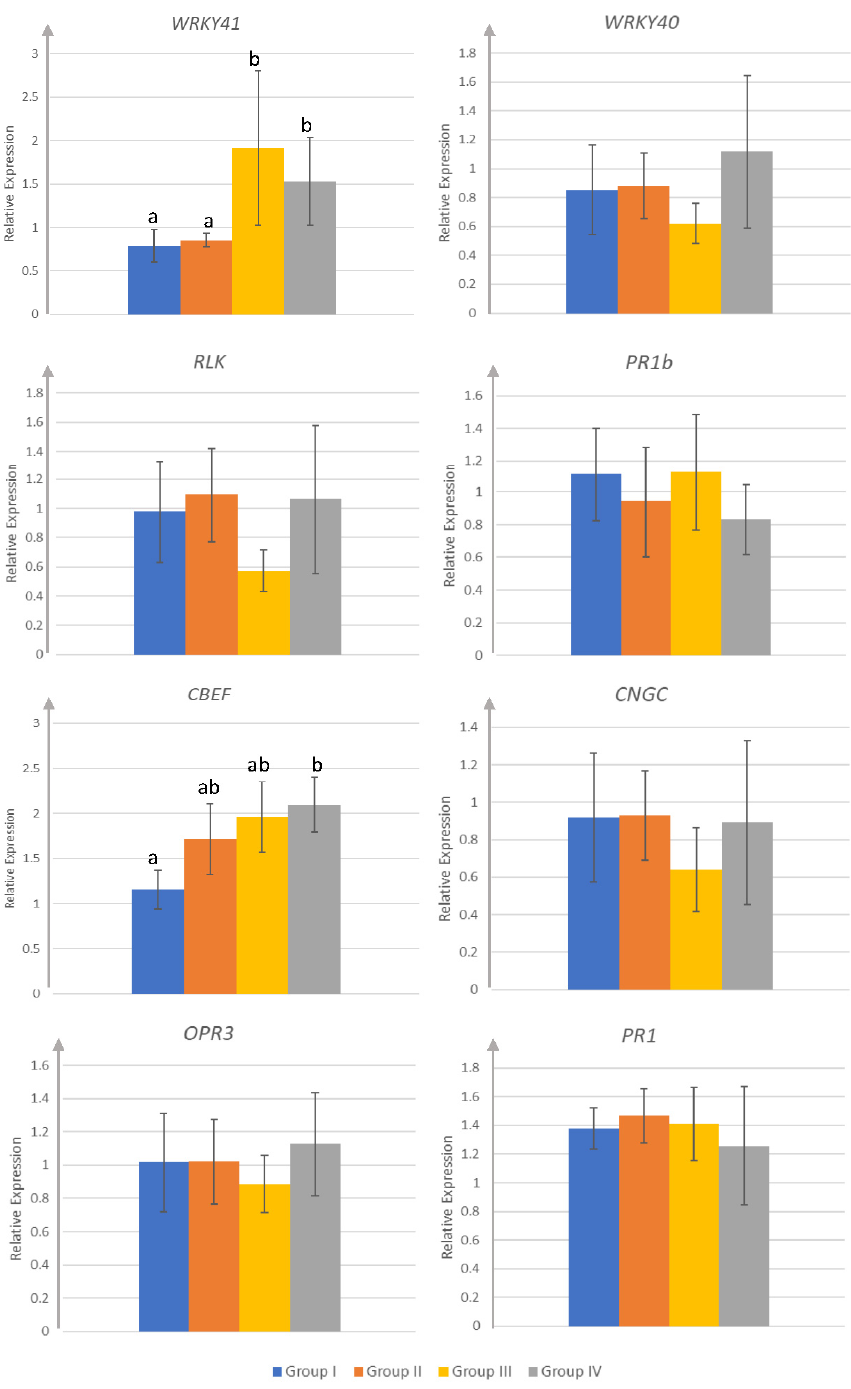
Figure 2. Transcript accumulation of WRKY41 , WRKY40 , RLK , PR1b , CBEF , CNGC , OPR3 and PR1 , upon different levels of Fusarium spp. infection (group I, group II, group II, group IV) growing under field conditions. Transcript levels were determined by qPCR. Error bars indicate the standard error of the mean. Significant differences are identified with different lowercase letters.